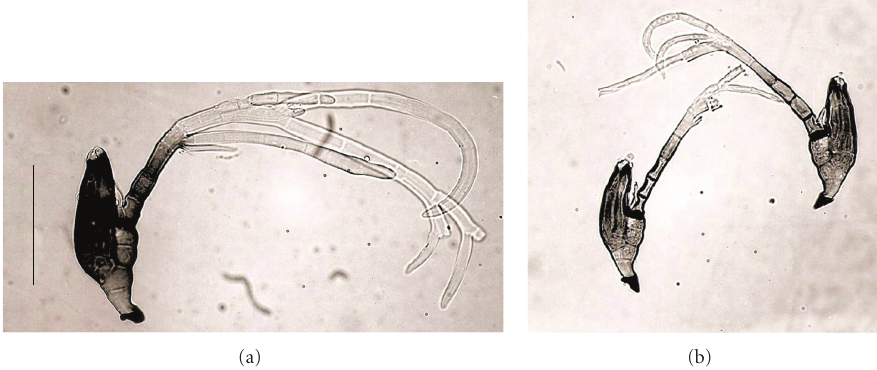
Figure 5: Laboulbenia camponoti from Camponotus sylvaticus (Spain); line: 1mm. (a) A mature specimen; (b) two immature specimens.